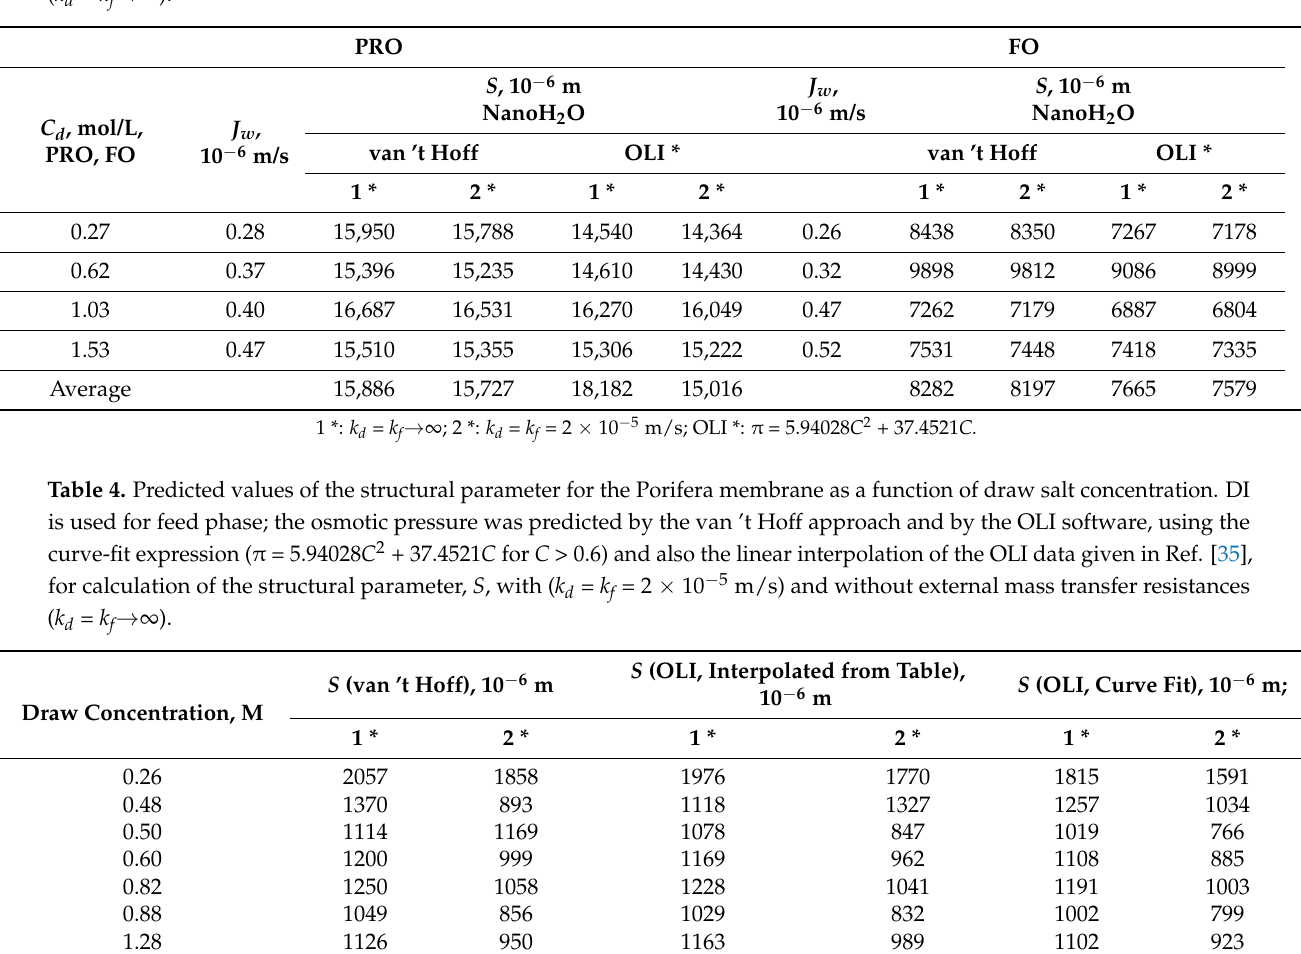
Table 3. Predicted values of the structural parameter for NanoH 2 O membrane as a function of draw salt concentration. DI is used for the feed phase; the osmotic pressure was predicted by the van ’t Hoff approach and by the OLI software for calculation of the structural parameter, S , with ( k d = k f = 2 × 10 − 5 m/s) and without external mass transfer resistances ( k d = k f → ∞ ).